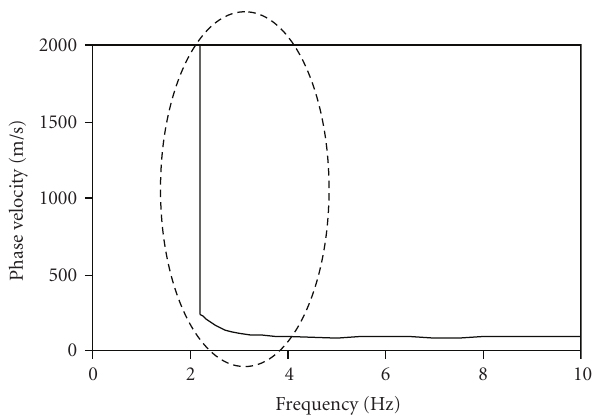
Figure 9: Dispersion curve for the fundamental mode of the passive roadside MASW method for NRC site. The part of curve that is located inside the dashed ellipse ( ≤ 5Hz) comes from the passive roadside test.